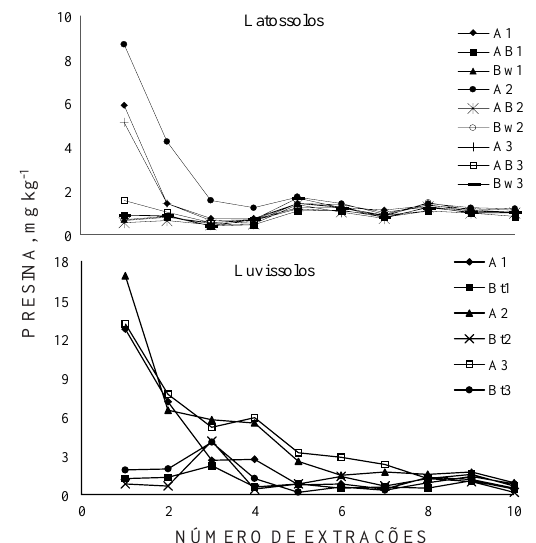
Figura 2. Curvas de dessorção do fosfato após dez extrações sucessivas com membranas de resina trocadora de íons, em amostras de horizontes de perfis de três toposseqüências de Latossolos (A1, AB1, Bw1; A2, AB2, Bw2; A3, AB3, Bw3) e três de Luvissolos (A1, Bt1; A2, Bt2; A3, Bt3), do semi-árido de